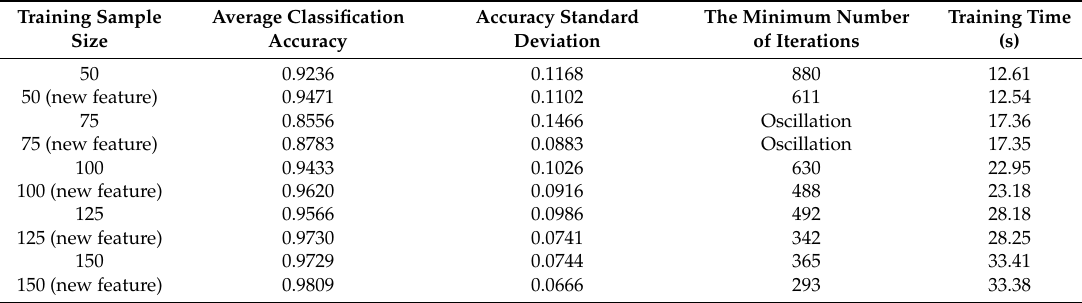
Table 13. Different training sample size model training results indicators comparison.